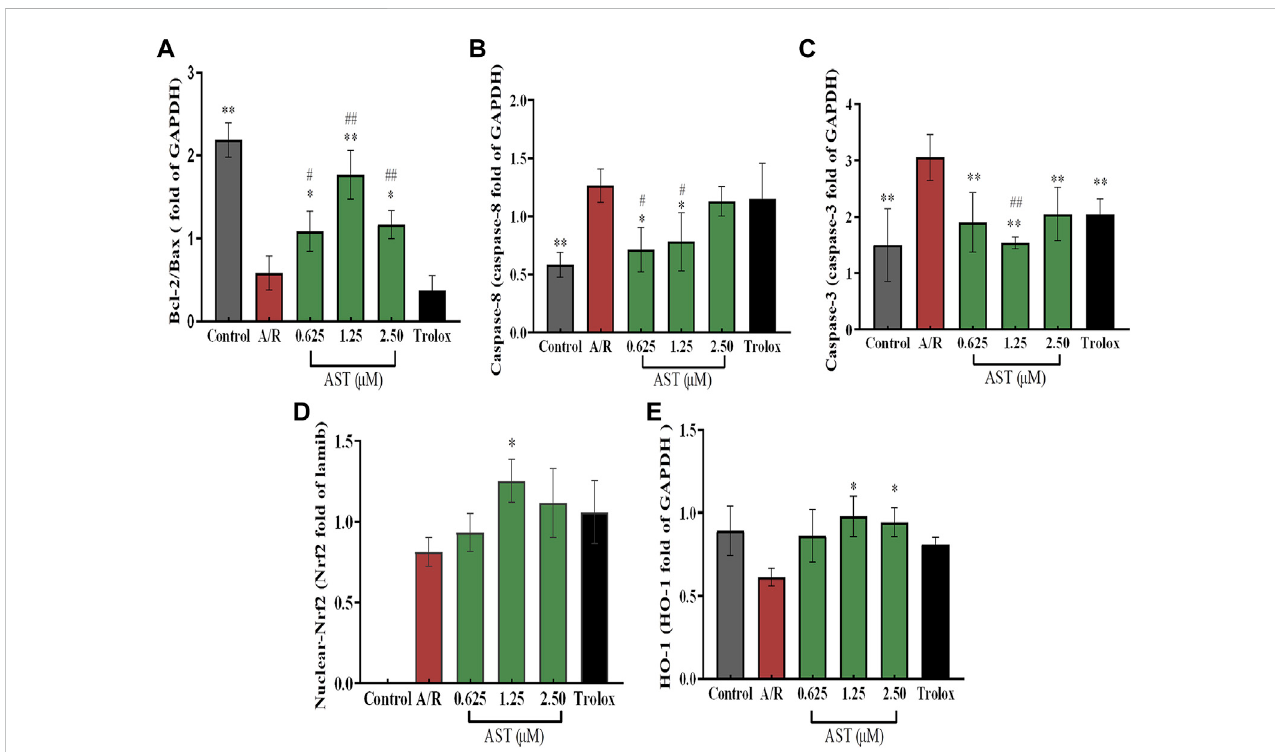
FIGURE 4 Astaxanthin pretreatment reduced apoptosis-related protein content (A – C) and enhanced nuclear Nrf2 and HO-1 protein content (D,E) in cardiomyocytes after A/Rinjury. *, vs. A/R group (* p < 0.05; ** p < 0.01); # , astaxanthinvs. Troloxgroup ( # p < 0.05; ## p < 0.01). A/R, anoxia reoxygenation; AST, astaxanthin.